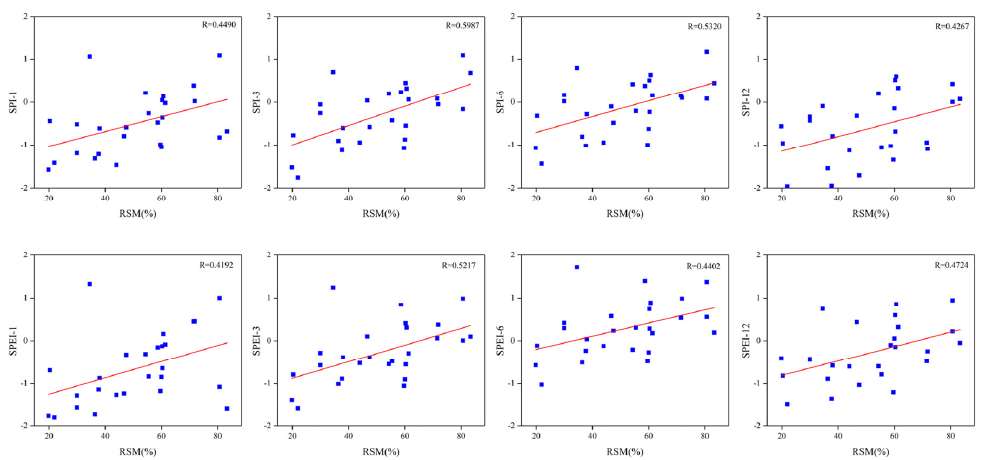
Figure 11. The correlations between the soil relative humidity and the SPI/SPEI at 1-, 3-, 6-, and 12-month